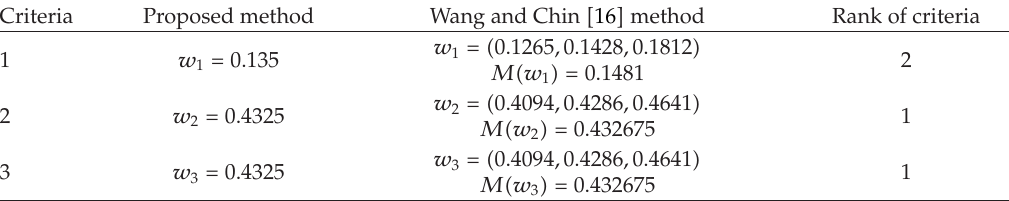
Table 5: The obtained weights of proposed method and Wang and Chin (cid:4) 16 (cid:5) method for